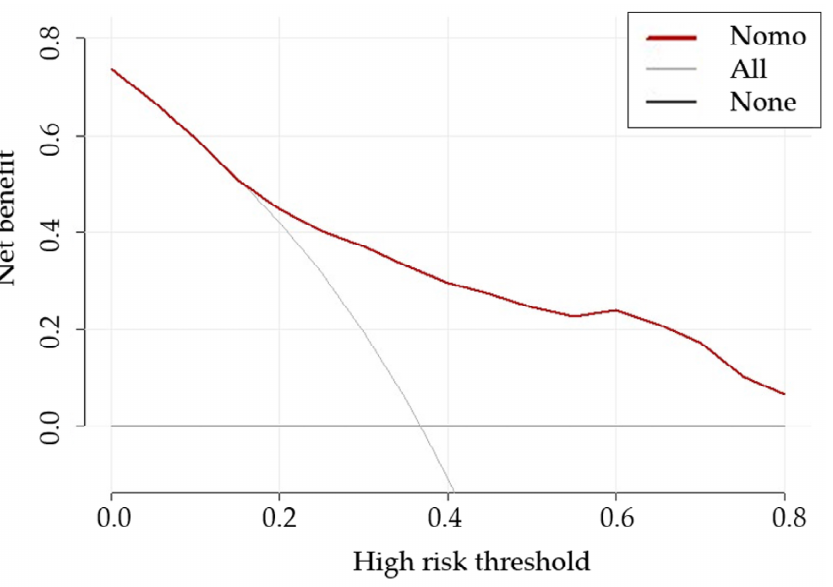
Figure 5. Decision curve analysis to assess the clinical utility of the proposed nomogram. The grey (All) and black (None) lines indicate the assumptions of all of the patients with and without LNM, respectively. The red line represents the performance of the nomogram and shows that the net clinical benefits can be achieved over a wide range of threshold possibilities. Abbreviations: LNM, lymph node metastasis; nomo,